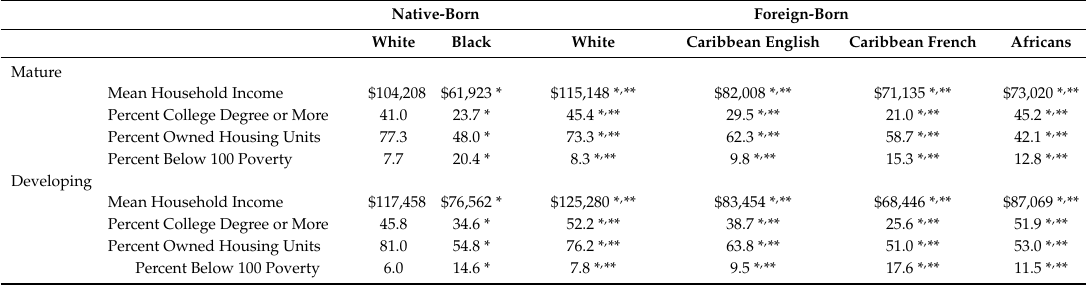
Table 2. Selected SES Characteristics by Suburban